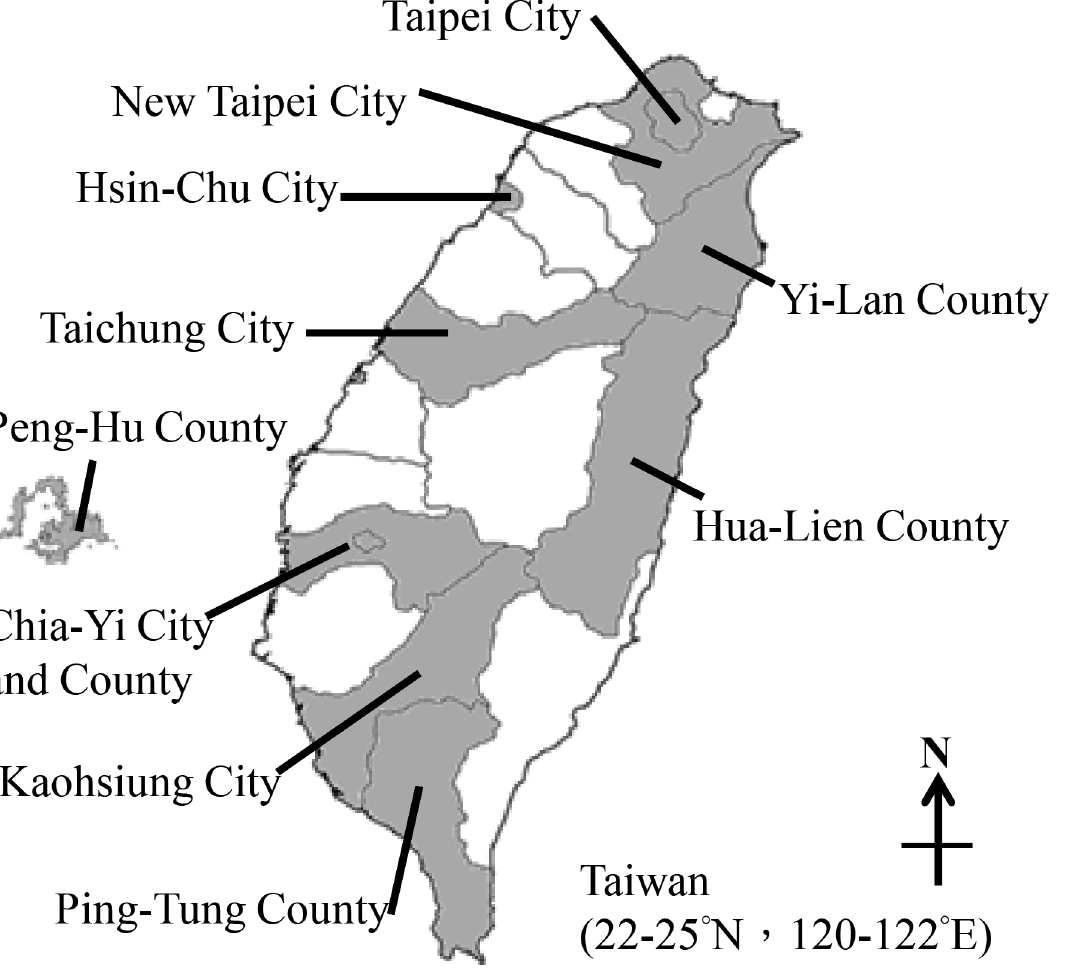
Fig 1. Eleven sampling sites of the TEST study in